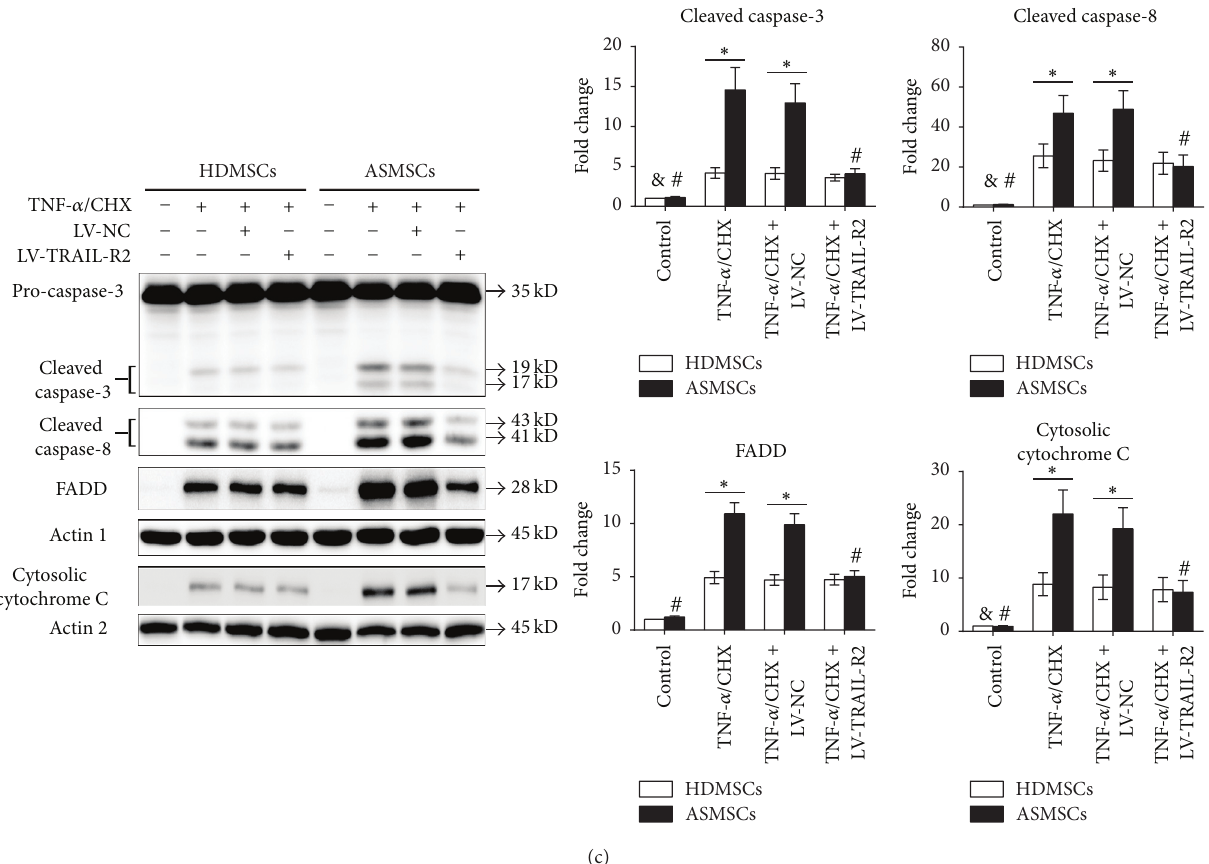
Figure 6: Lentiviruses encoding shRNA-TRAIL-R2 partly inhibited the apoptosis of ASMSCs while having a limited effect on the apoptosis of HDMSCs. (a) The rate of ASMSC apoptosis ( 𝑛 = 22 ) was decreased after Lv-TRAIL-R2 transduction, while no apparent changes were found for HDMSCs ( 𝑛 = 28 ). (b) In ASMSCs ( 𝑛 = 22 ), Lv-TRAIL-R2 reduced FADD and total caspase-8 expression while having a limited effect on total caspase-3 and total cytochrome C gene expression. In HDMSCs ( 𝑛 = 28 ), Lv-TRAIL-R2 had a limited effect on the expression of all four genes. (c) Lv-TRAIL-R2 did not affect the protein levels of cleaved caspase-3, cleaved caspase-8, FADD, or cytosolic cytochrome C in HDMSCs ( 𝑛 = 28 ) but reduced them in ASMSCs ( 𝑛 = 22 ). Values are presented as the mean ± SD. ∗ indicates 𝑃 < 0.05 between HDMSCs and ASMSCs. & indicates 𝑃 < 0.05 for the TNF- 𝛼 /CHX group compared with other HDMSC groups. # indicates 𝑃 < 0.05 for the TNF- 𝛼 /CHX group compared with other ASMSC groups. Lv-NC refers to MSCs transduced by lentiviruses encoding a negative control sequence. Lv-TRAIL-R2 refers to MSCs transduced by lentiviruses encoding